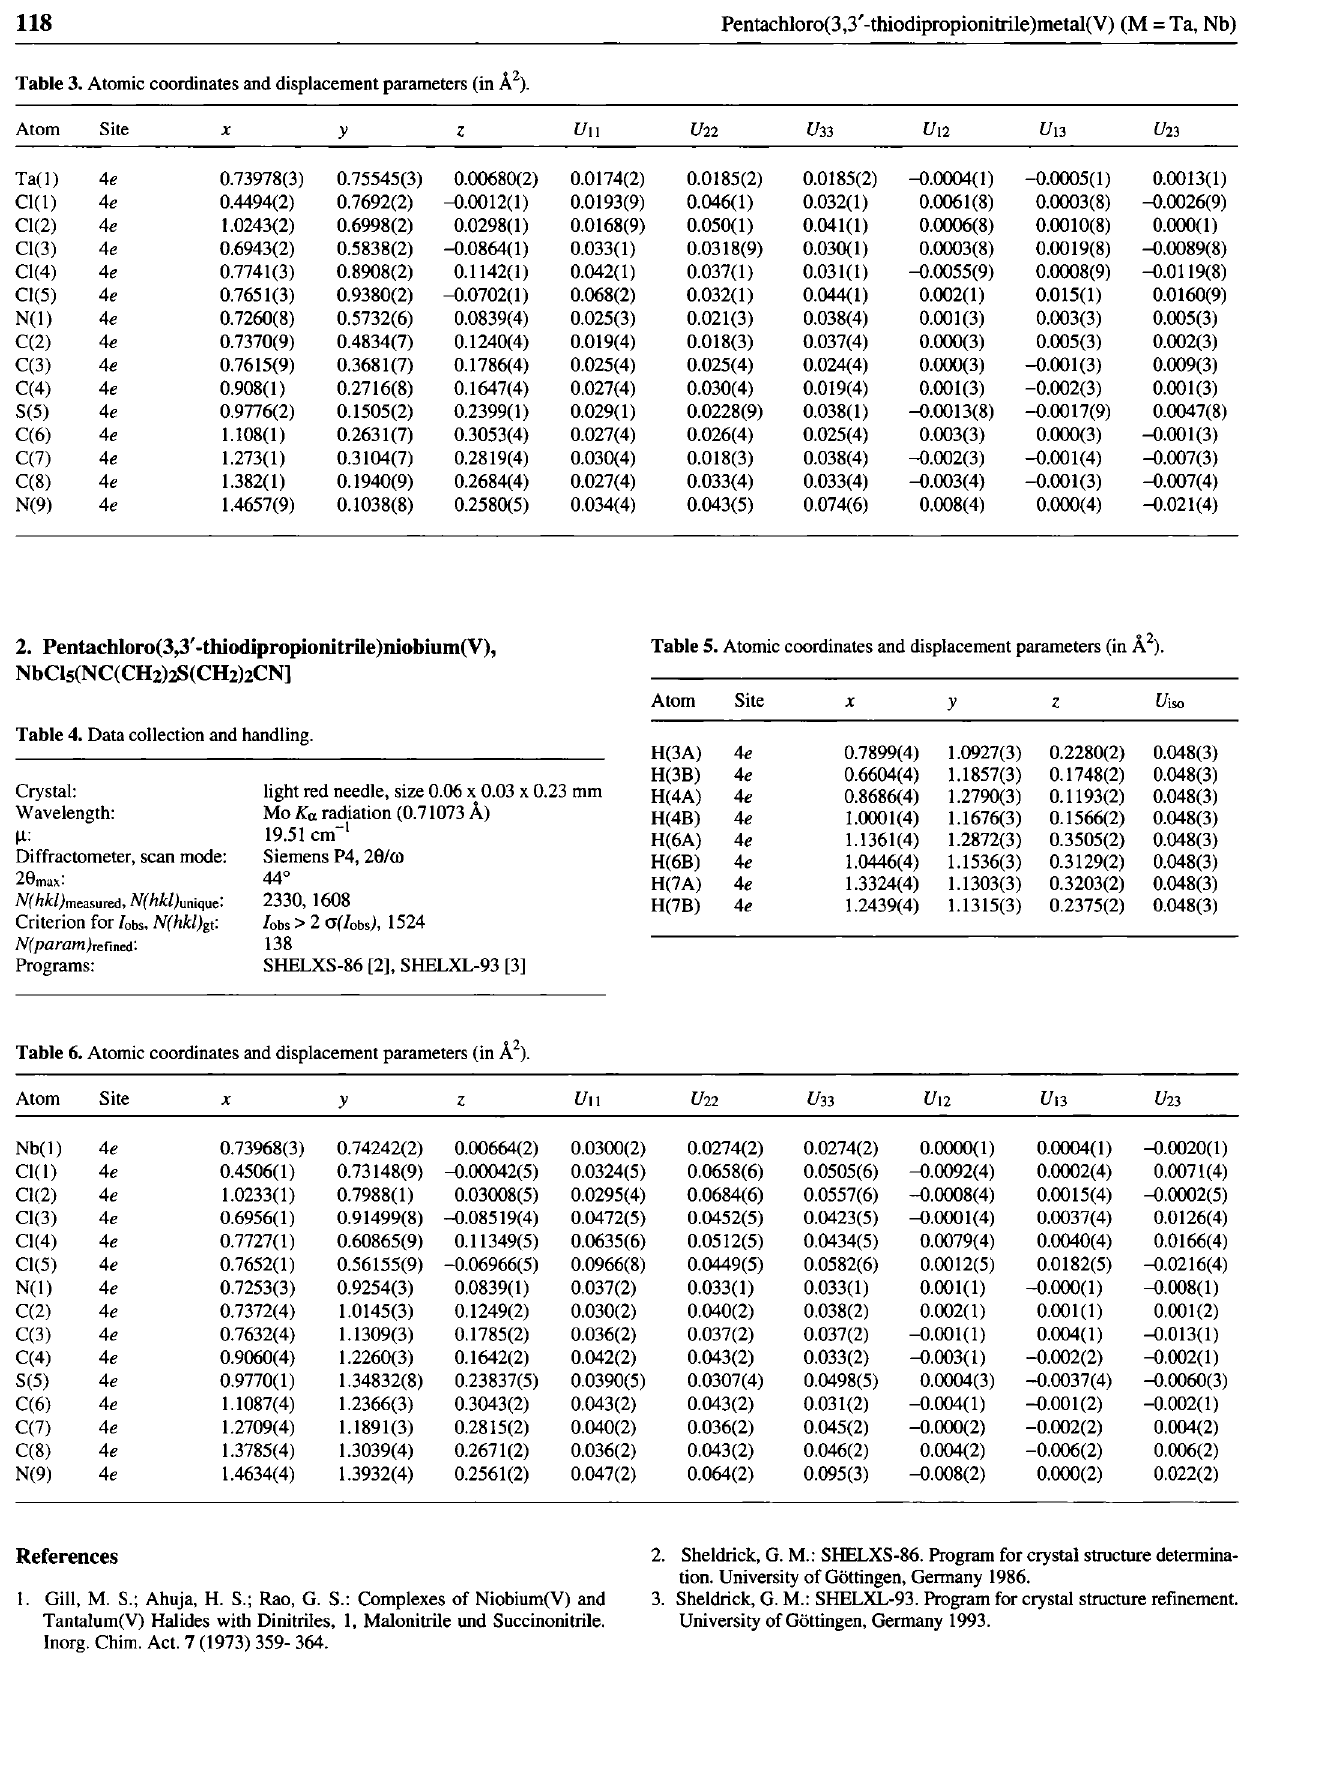
Table 3. Atomic coordinates and displacement parameters (in Â 2 ).